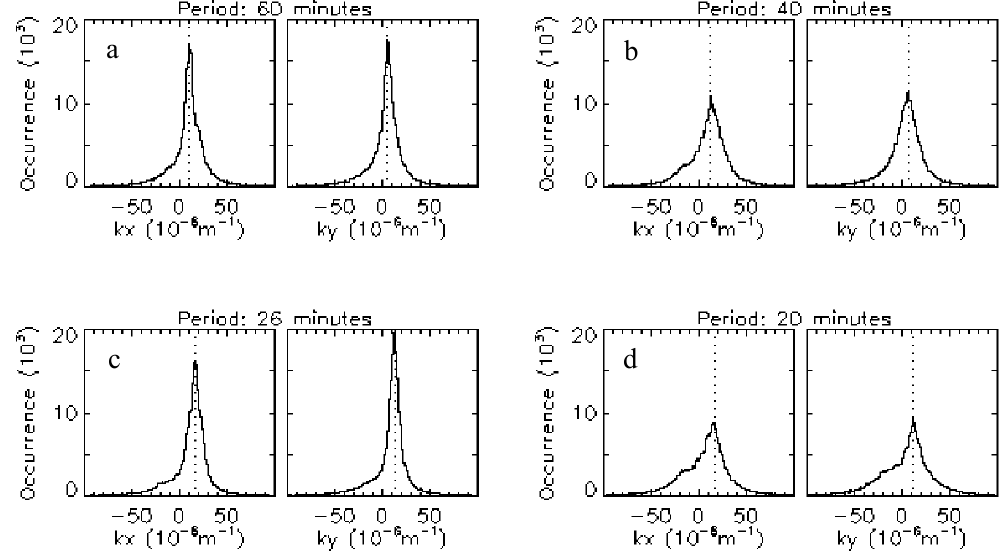
Fig. 7. Distributions of gravity wave number vector at periods of 60 (a) , 40 (b) , 26 (c) and 20 (d) min, respectively. The maxima of the distributions are used to estimate the wave wavelengths, phase velocities and azimuthal angles of propagation.